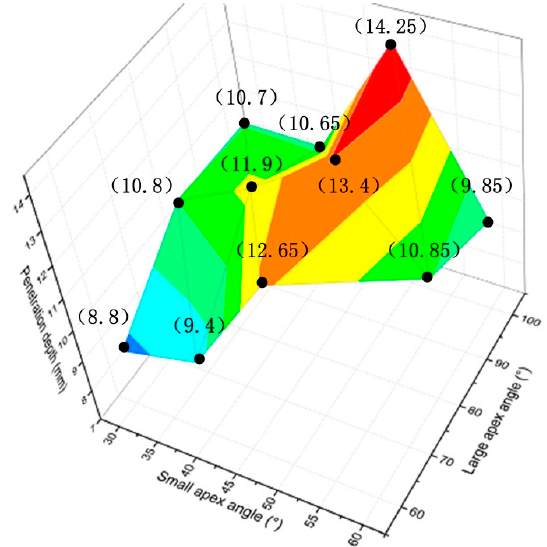
Figure 14. Penetration depths of different combinations of small and large apex angles.